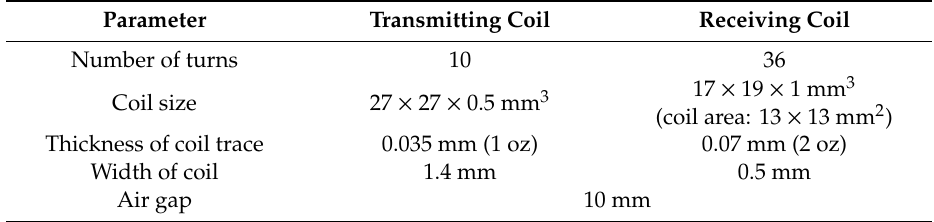
Table 3. Geometrical characteristic of wireless power transfer system coils for experiment.